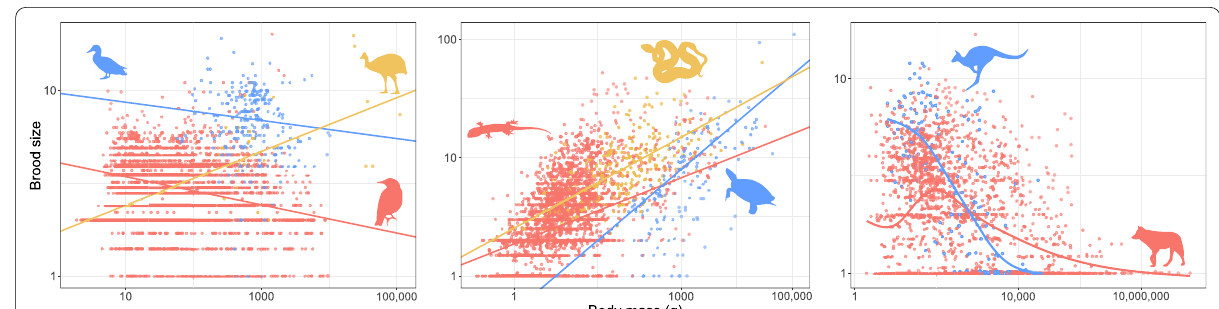
Fig. 6 Allometry of brood size. From left to right; a Aves (red: Neoaves, blue: Galloanserae, yellow: Palaeognathae), b Reptilia (red: Sauria, blue: Testudines, yellow: Serpentes) and c Mammalia (red: Eutheria; blue: Metatheria). Solid lines are regression slopes from PGLS analysis for Aves and Squamates. For Mammalia, regression lines are from a Generalized Additive model with knots (k